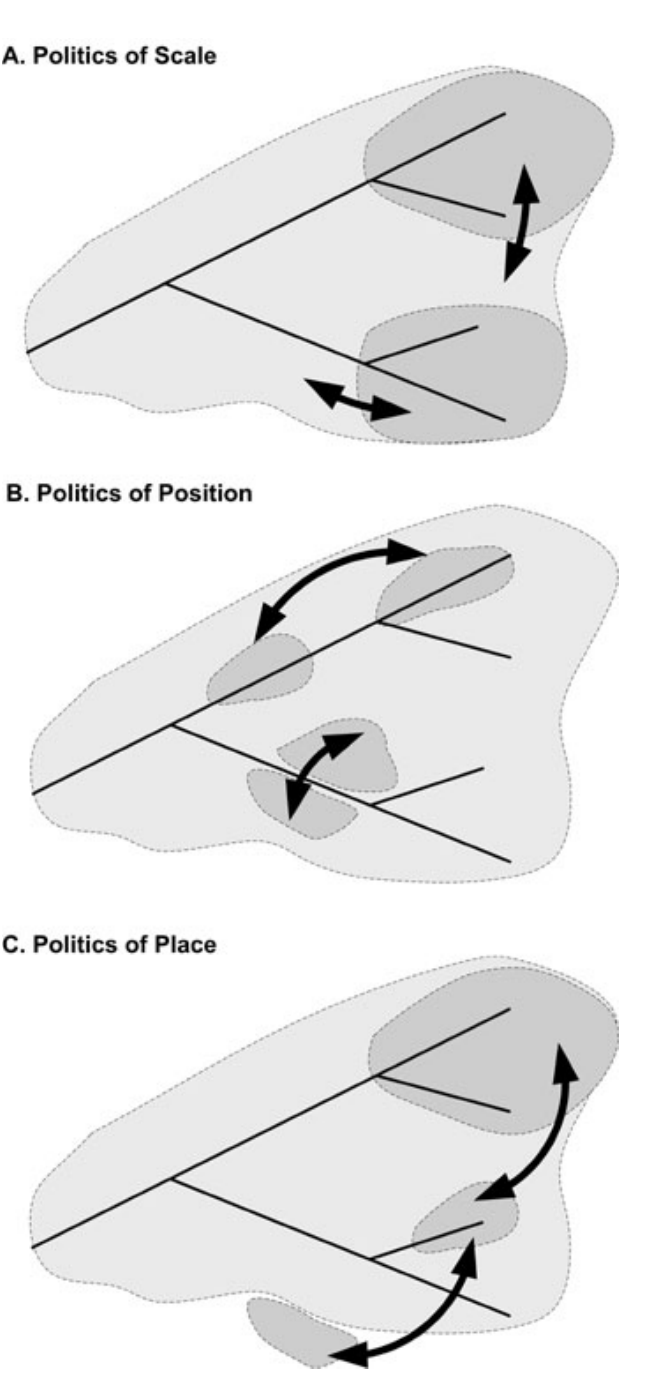
Fig. 1. A schematic representation of the politics of scale, position, and place around regional water resources. Dark thick arrows represent political relationships (e.g., contests, conflicts, negotiations) between different area (shaded). Solid lines represent rivers and the light-shaded area represents the river